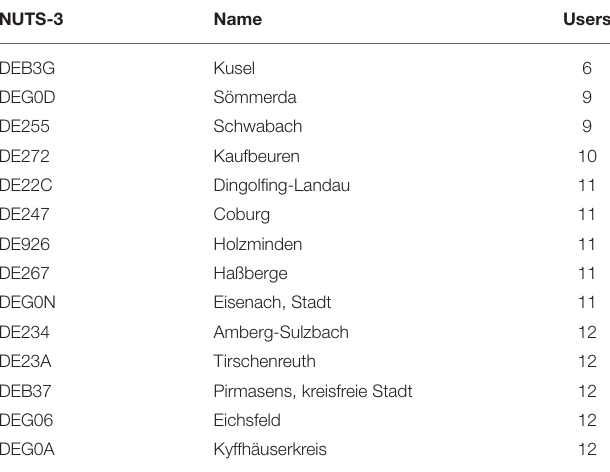
TABLE 1 | NUTS-3 regions with the fewest users based on Twitter